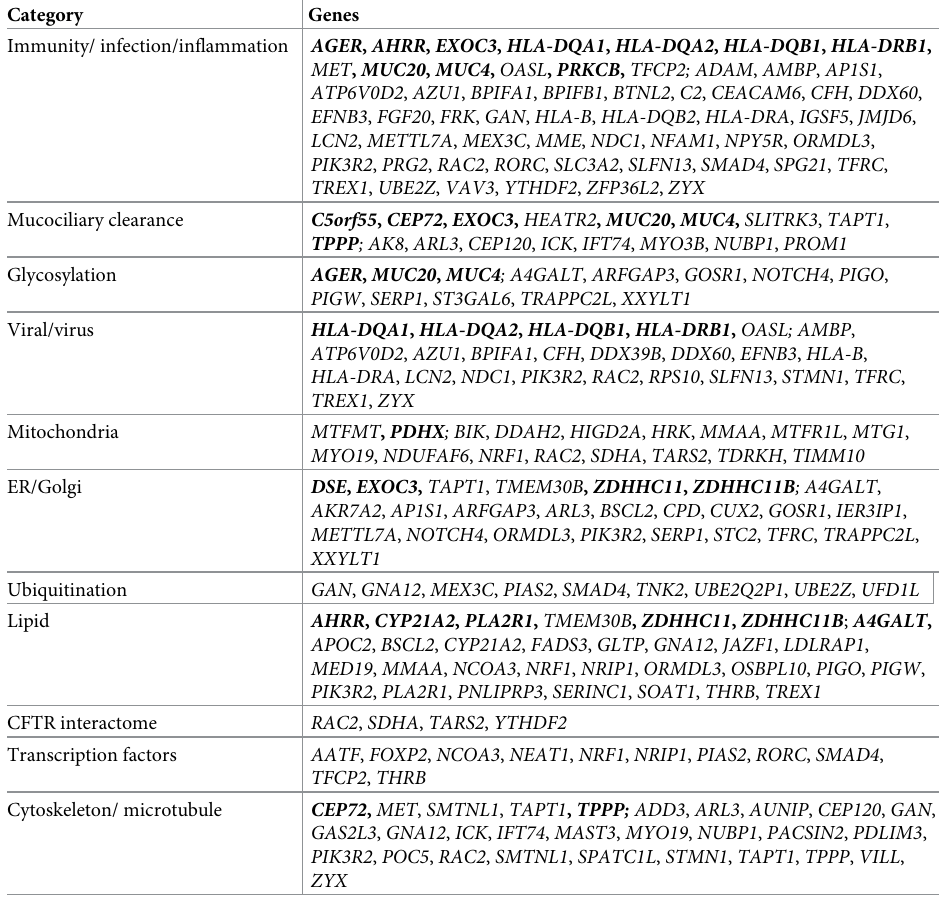
Table 2. Functional categories of significant genes (n = 149 out of 379) relevant to CF pathophysiology �